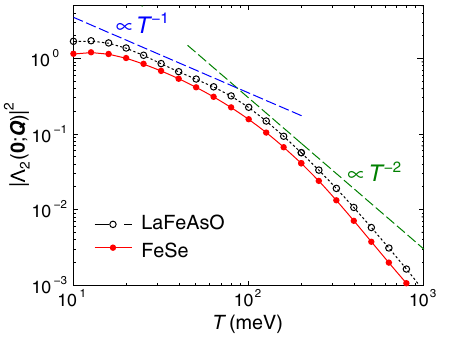
FIG. 11. T dependence of j Λ 2 ð 0 ; Q Þj 2 in LaFeAsO and FeSe models. Here, 512 × 512 k meshes are